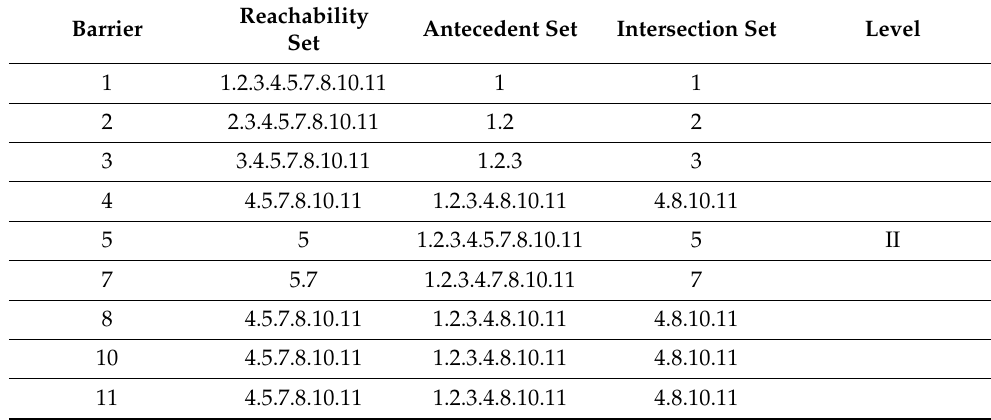
Table A5. Level Partitioning (Conventional Method)—2nd Iteration.